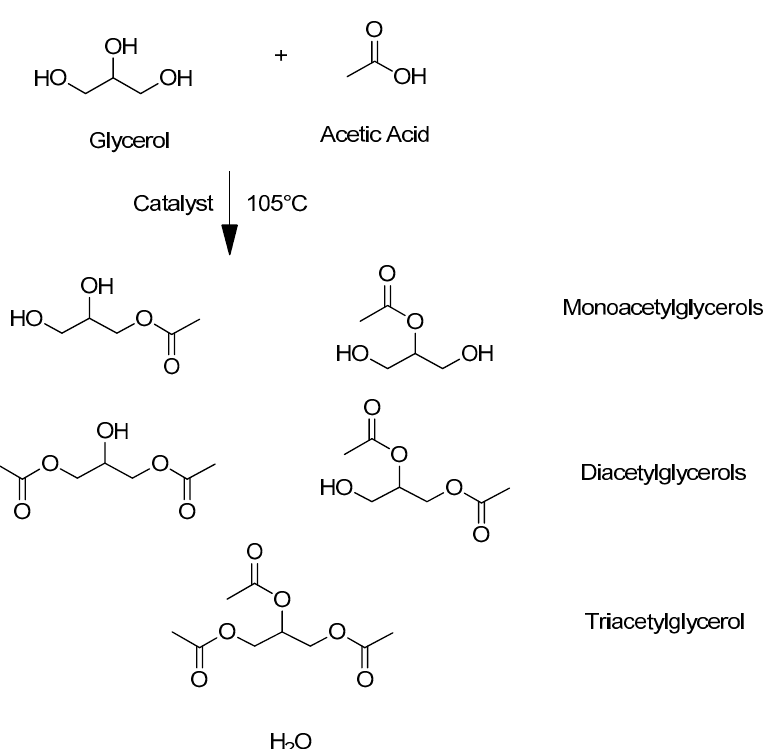
Figure 1. Esterification of glycerol with acetic acid .